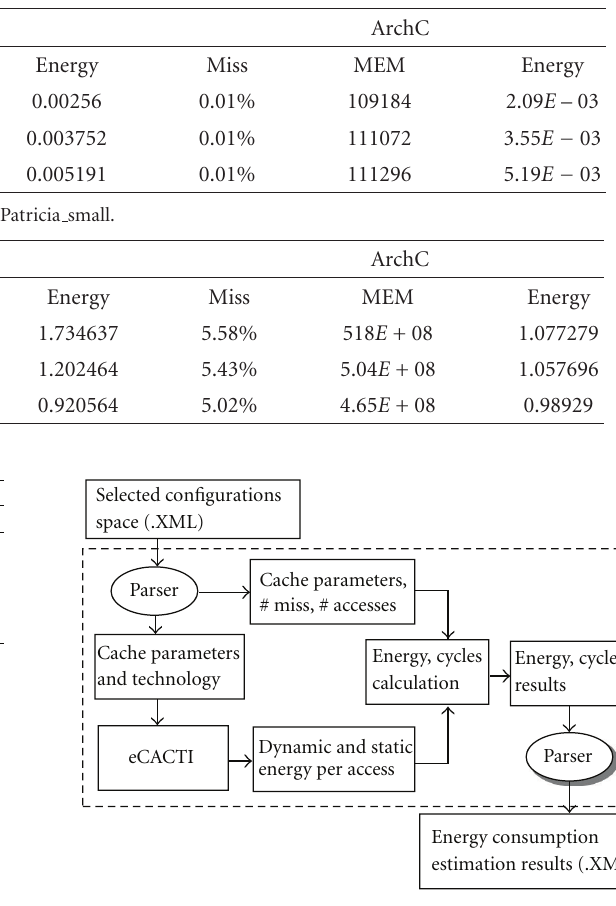
Figure 6: Energy calculation